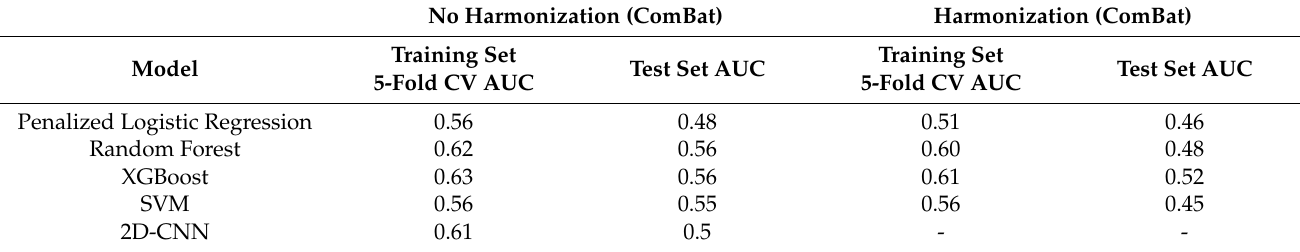
Table 2. Results of the models developed for the 1-year relapse classification. Mean AUC of the 5-fold cross-validation (CV) obtained during model training and AUC of the test set for the analysis without or with ComBat harmonization are reported.